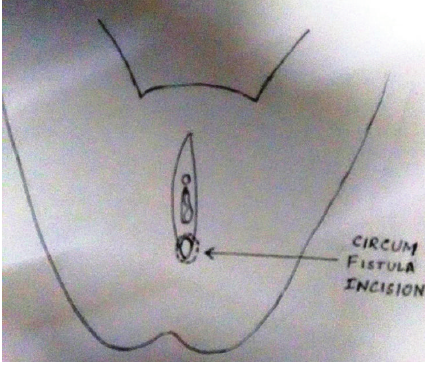
Figure 7: Incision around the fistulous opening.